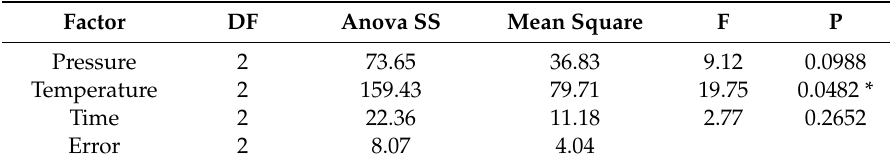
Table 3. Variance analysis of orthogonal experimental design for extraction optimization of AZ-SFE. p <